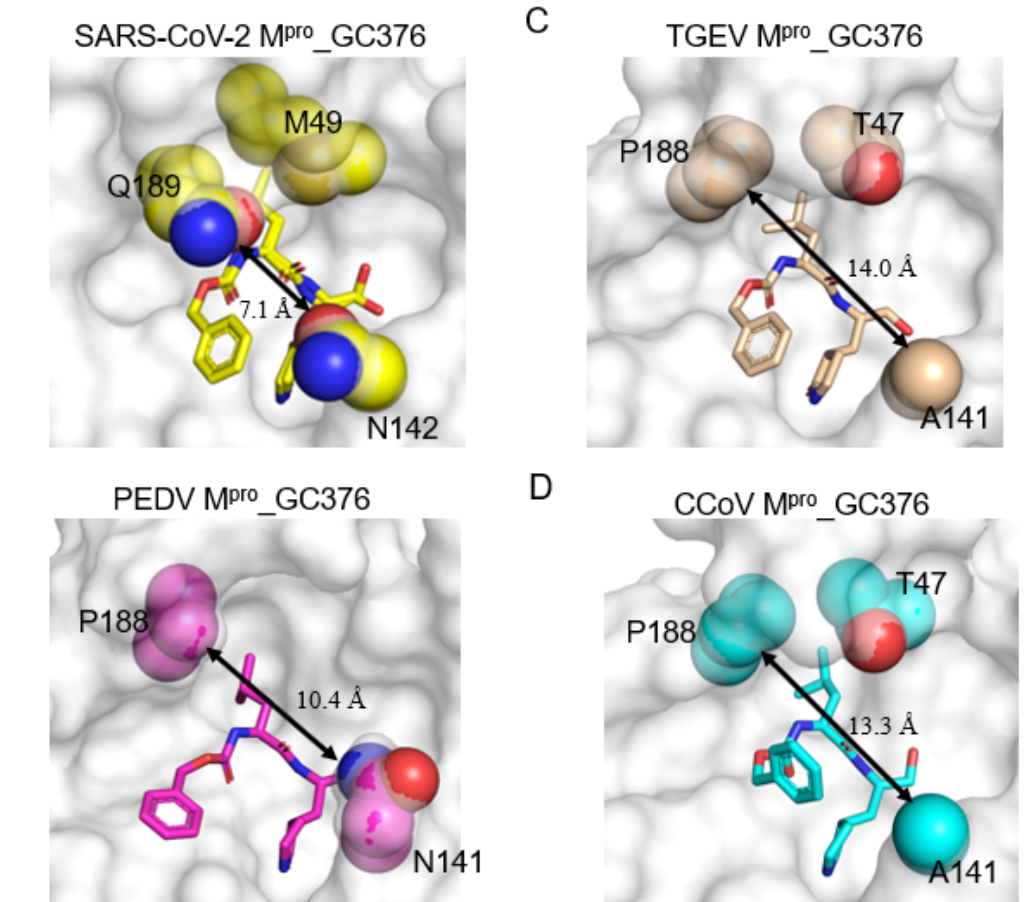
Figure 5. Comparison of the size of entrance of substrate-binding pocket among different CoV M pro s. Surface presentation of the substrate-binding pocket of: ( A ) SARS-CoV-2 M pro _GC376 (PDB: 7CB7, yellow); ( B ) PEDV M pro (PDB: 6L70, magenta); ( C ) TGEV M pro _GC376 (PDB: 4F49, wheat); ( D ) CCoV M pro _GC376 (cyan). The three structural features demonstrated in Figure 4 within the substrate- binding pocket are shown in spheres as indicated. The shortest distances between sidechains of Q189/P188 and N142/(N/A)141 from SARS-CoV-2 M pro /animal CoV M pro s are measured and indicated by double-headed arrows. GC376s are shown in sticks.